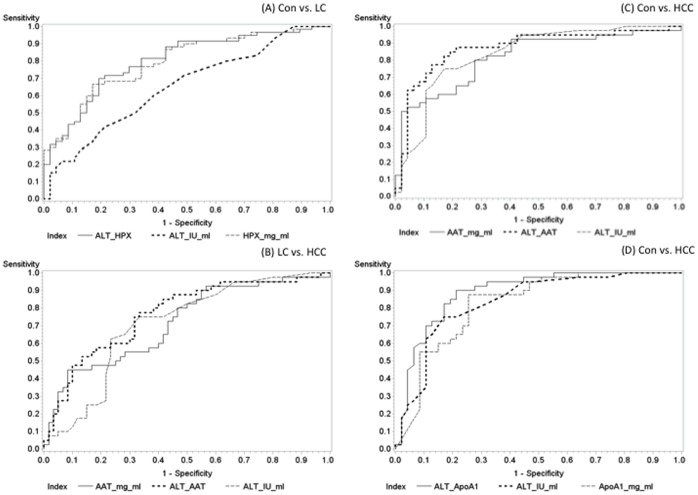
ROC Curves for Multiplexed Proteins in GLCS.(A–D) ROC curves demonstrating shifts in discriminatory ability for labeled comparisons between putative markers and ALT.